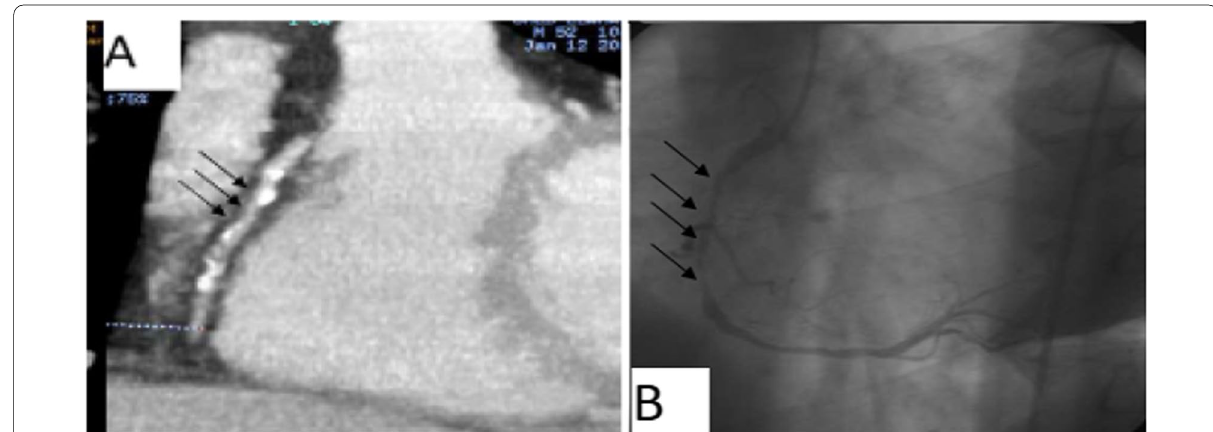
Fig. 4 A 61-year-old male patient complaining of recurrent attacks of stabbing chest pain radiating to the left arm. A CT angiography showed RCA long partially calcified lesions (three black arrows) (CAD-RADS 4). B Conventional angiography images showed RCA mid-segment long stenotic lesions (multiple arrows) in complete agreement with the CT